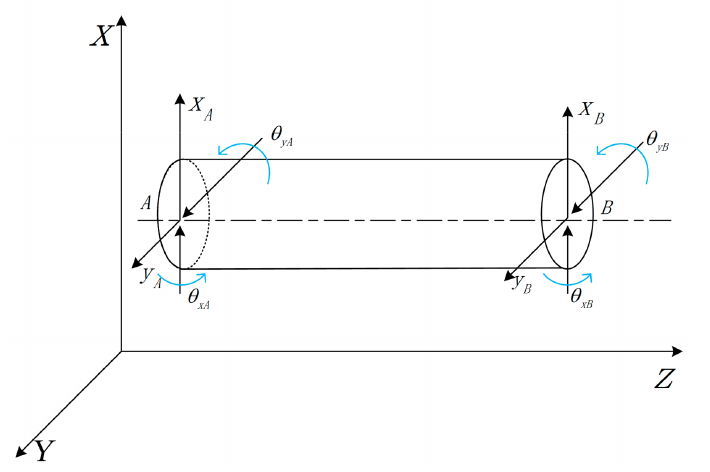
Figure 1. Elastic shaft